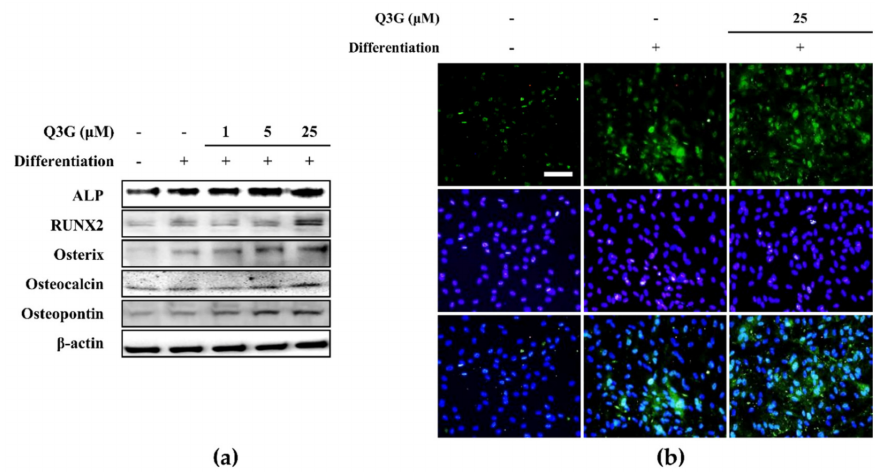
Figure 4. E ff ect of Q3G on osteoblastogenesis marker protein expression. Analysis of protein expression was carried out by Western blotting ( a ) and immunofluorescence staining ( b ) of osteo-induced hBM-MSCs at day 10 di ff erentiation. Q3G was treated with initial di ff erentiation induction (3 days) and Q3G was not present in subsequent media changes. β -actin was used as internal loading control. Scale bar: 100 µ m.